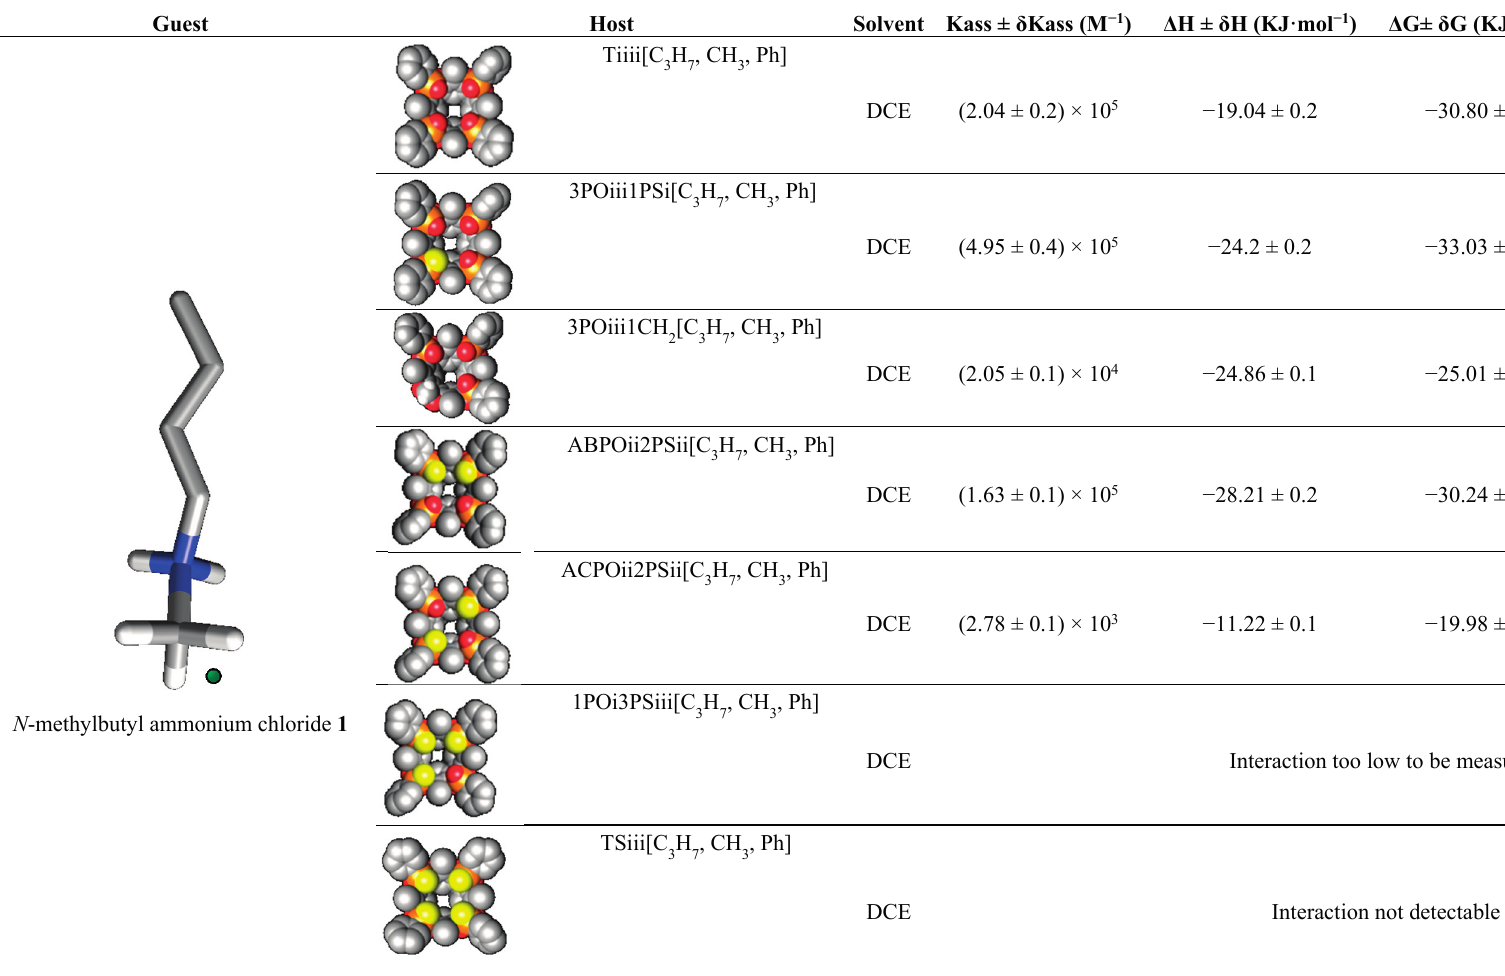
H , CH , Ph] , 3POiii1PSi[C 3 7 3